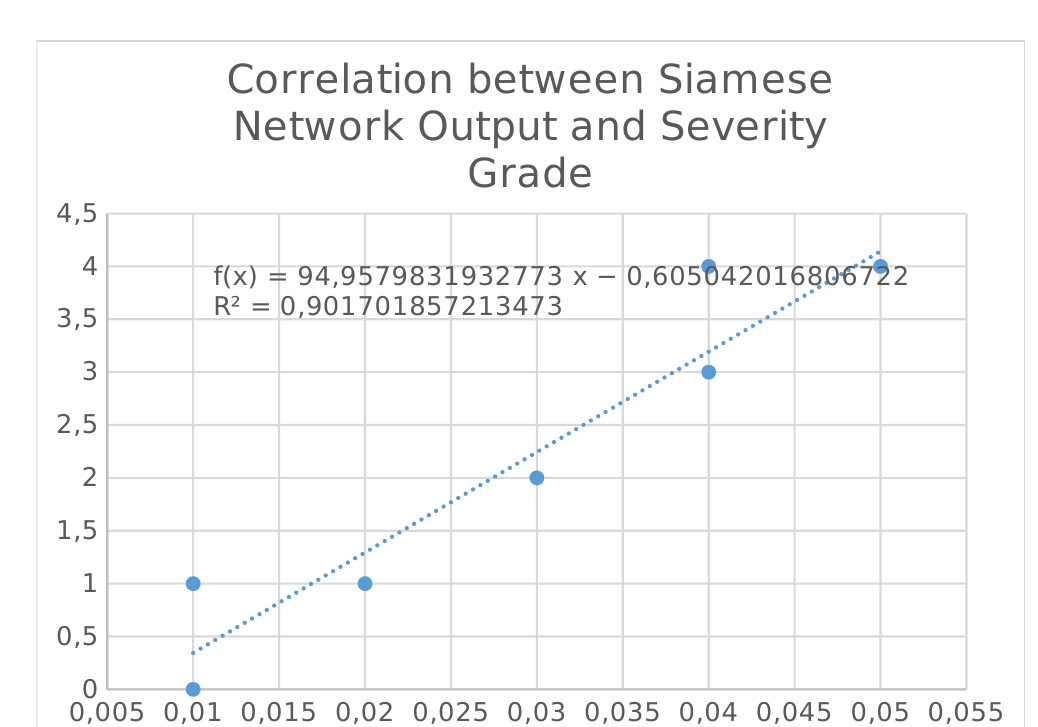
Figure 6: Scatter plot between the Siamese network output and